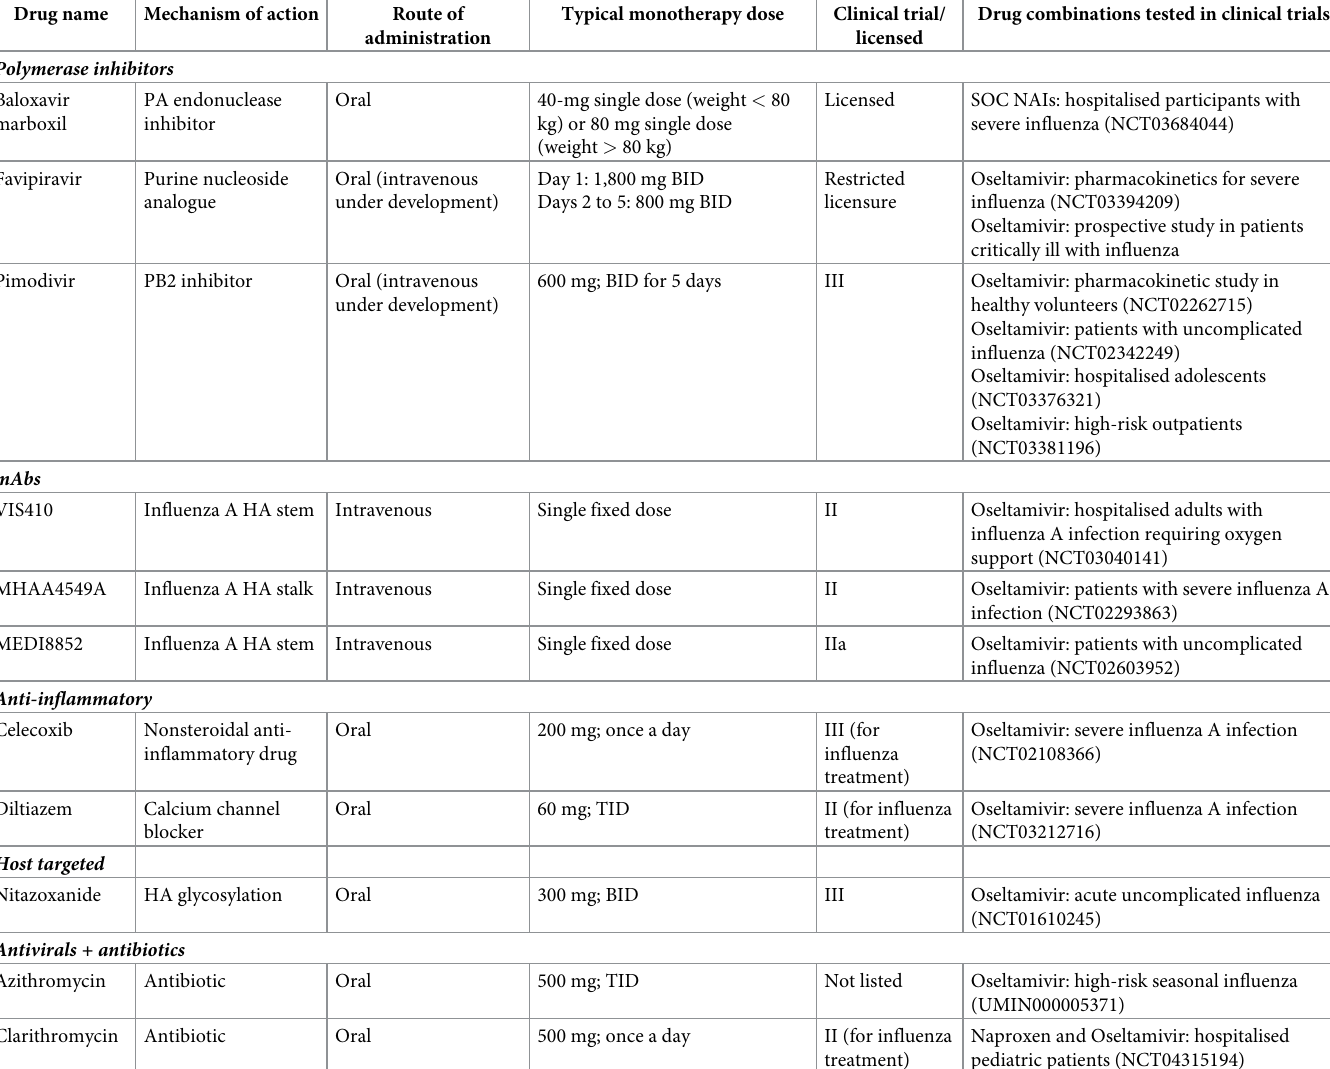
Table 1. Summary of antiviral drugs and adjunctive therapies used in combination treatment in clinical trials. Drug